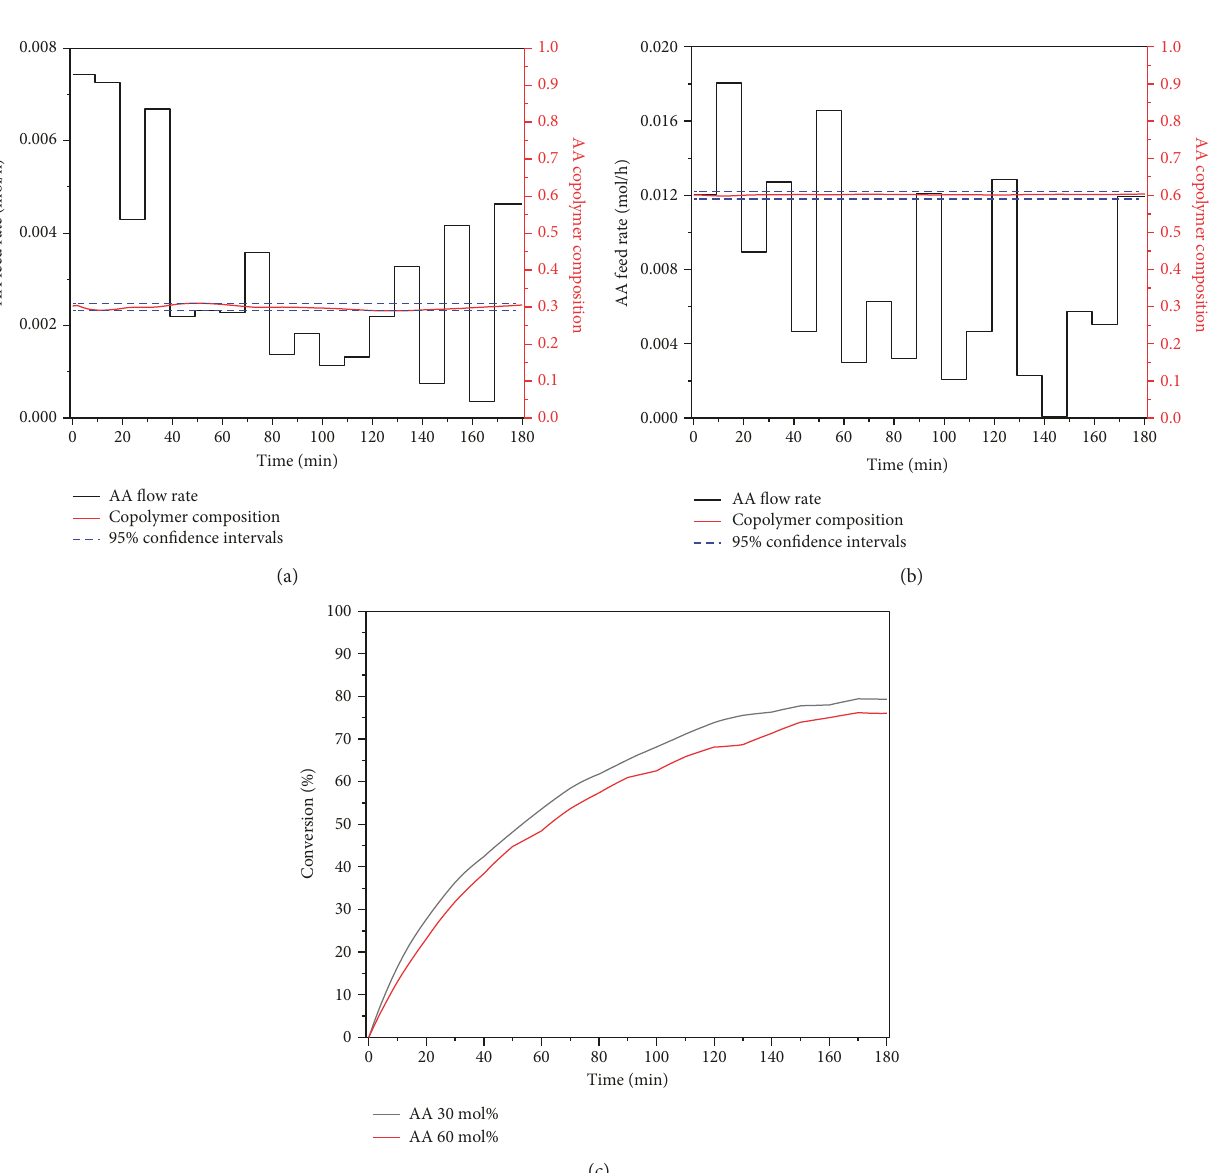
Figure 7: Dynamic behavior of vinyl acetate/acrylic acid suspension copolymerizations in semibatch operation mode. AA feed fl ow rate and AA copolymer composition pro fi le for y = 30 mol% (a) and y = 60 mol% (b) and conversion pro fi les AA AA